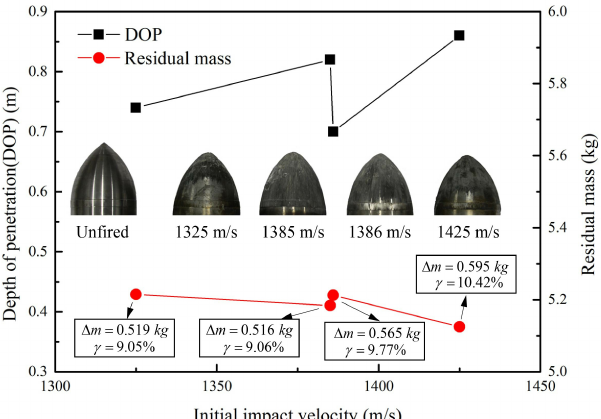
Figure 2. Results of impact experiments including depth of penetration H , mass loss ∆ m , mass loss rate γ , and final nose of the residual